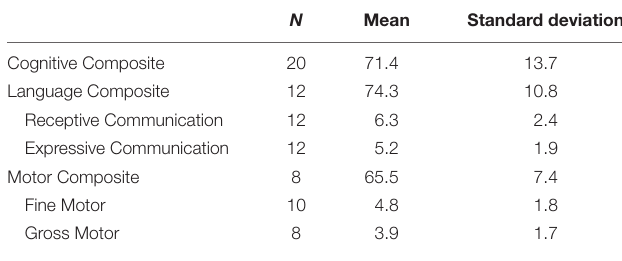
TABLE 1 | Mean Scores on the Bayley-III.